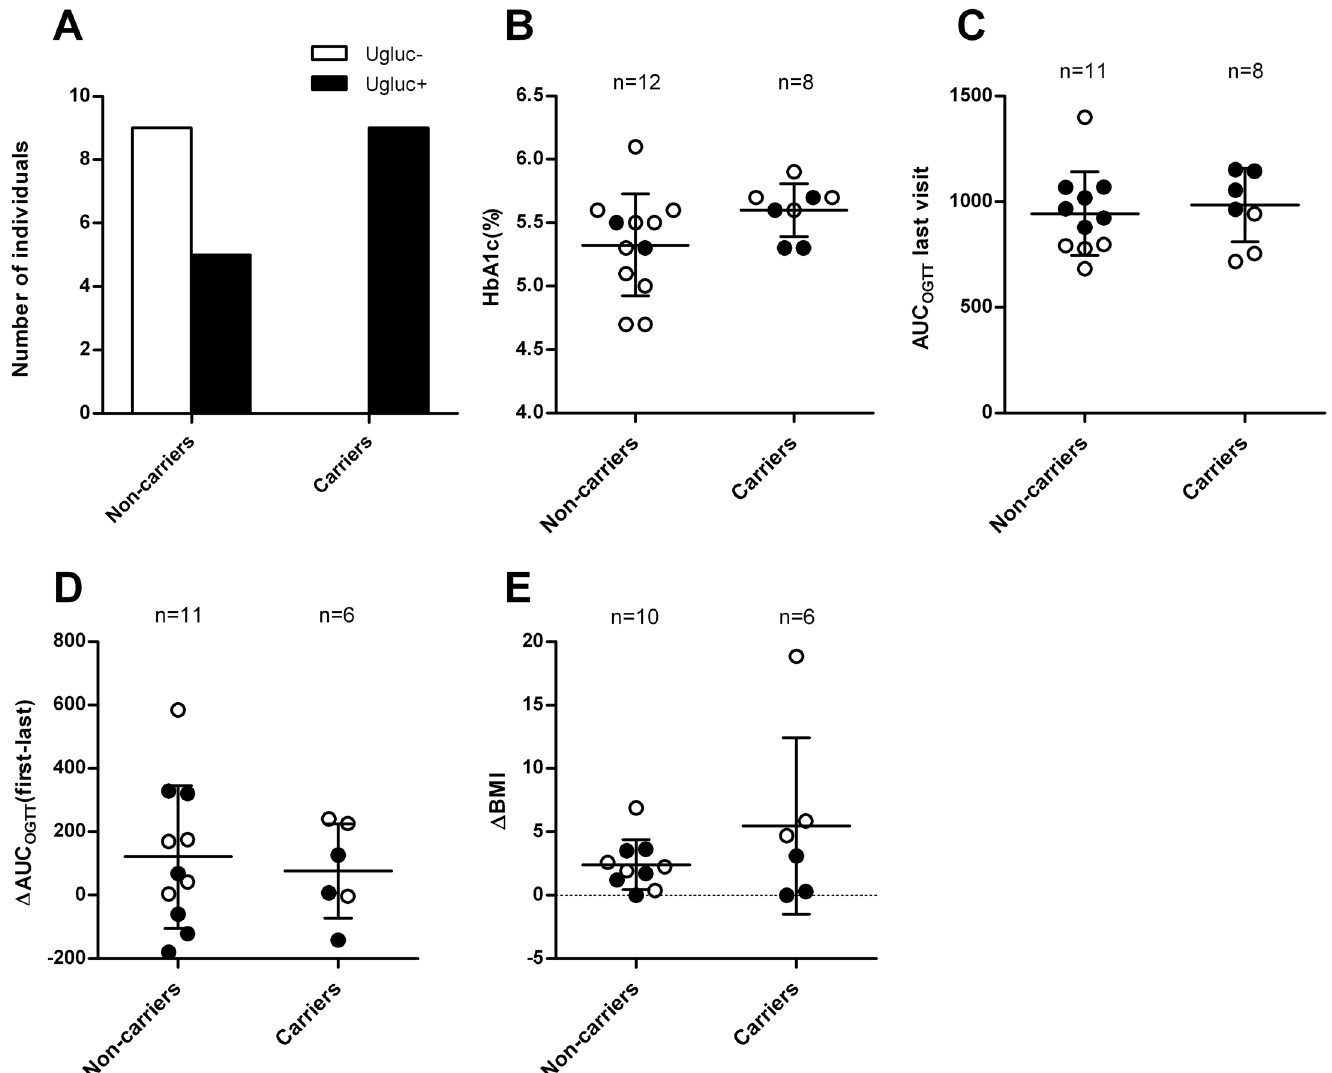
Fig 2. Carriers of the deletion are not protected against deterioration of glycemic status A) glycosuria in carriers and non-carriers of the mutation deletion (c300-303+2del). All but one of the non-carriers displaying glycosuria had impaired fasting glucose, impaired glucose tolerance or type 2 diabetes, B) HbA 1c at examination did not differ between carriers and non-carriers (p = 0.09), C) Area under the glucose curve during the last OGTT (p = 0.64), D) Change in area under the glucose tolerance from the first to the last OGTT (p = 0.67, mean follow up time 11 years), E) Change in BMI during the follow-up period. The white dots in the graphs represent non-diabetic individuals and the black dots individuals with impaired fasting glucose/impaired glucose tolerance/type 2 diabetes. The error bars show the